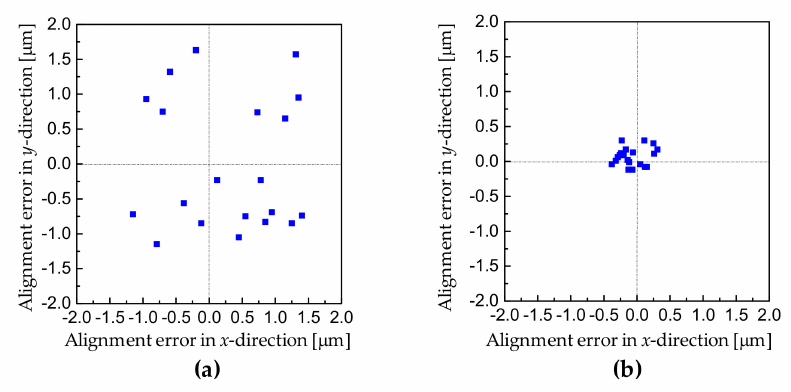
Figure 9. The alignment errors in x - and y - directions after bonding: ( a ) alignment using the cross-and-box marks; ( b ) alignment using the moir é -based centrosymmetric grating